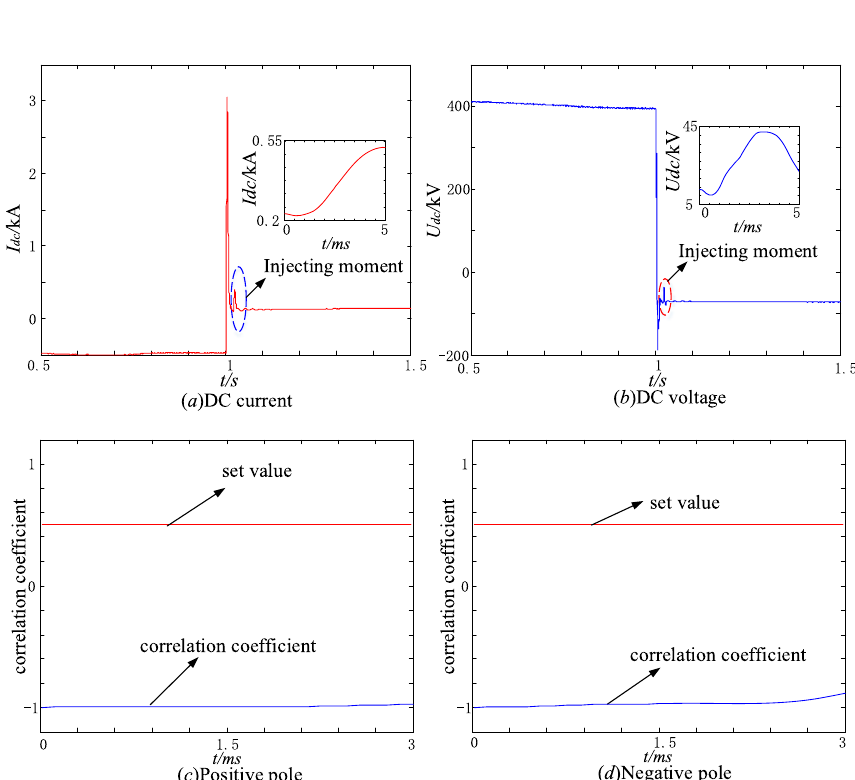
Fig. 12 f 1 point pole-to-pole